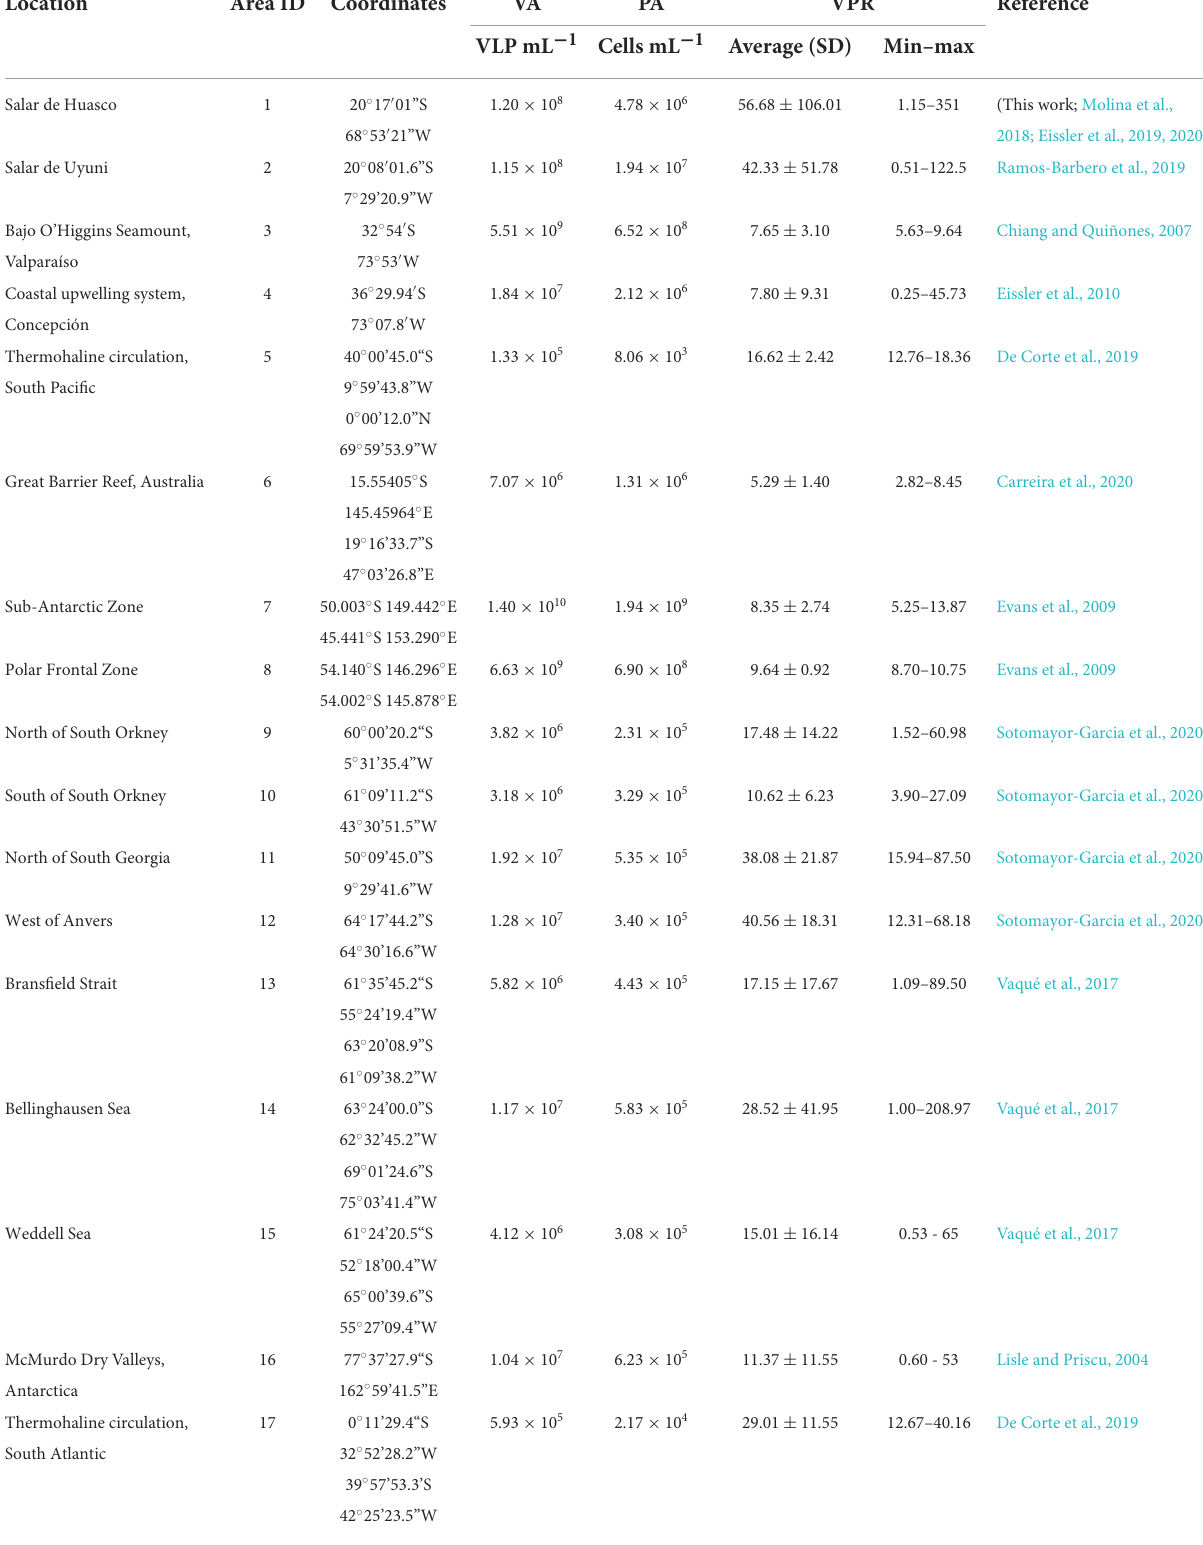
TABLE 1 Mean values of viral (VA) and prokaryotic abundance (PA); average, standard deviation (SD) and range (minimum to maximum) of VPR in aquatic ecosystems of South